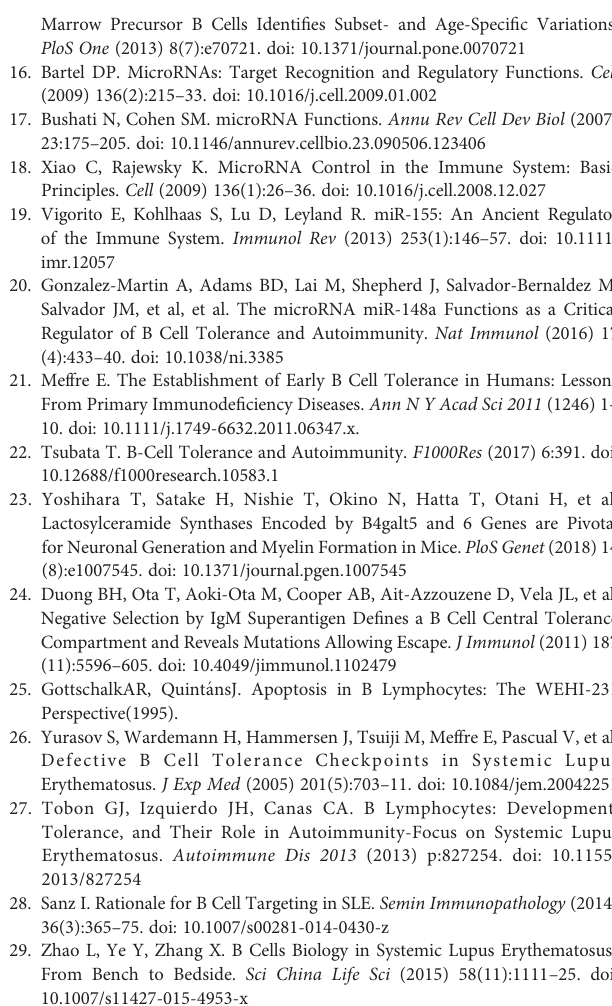
Supplementary Figure 2 | Heterozigous deletion of B4Galt5 does not compromise Bcelltolerance. (A) Representative fl owcytometryplotsshowingIgM+CD19+splenicB cells of IgMb-macroself mice reconstituted with bone marrow cells from B4galt5 fl / fl and Mb1Cre; B4galt5 fl /+ mice, as indicated, 8 weeks after reconstitution. (B) Graph showing percentage of IgM + CD19 + splenic B cells among total cells in mice analyzed in (A) . n=4 for B4galt5 fl / fl and n=6 for Mb1Cre;B4galt5 fl /+ mice. No statistical differences were found.